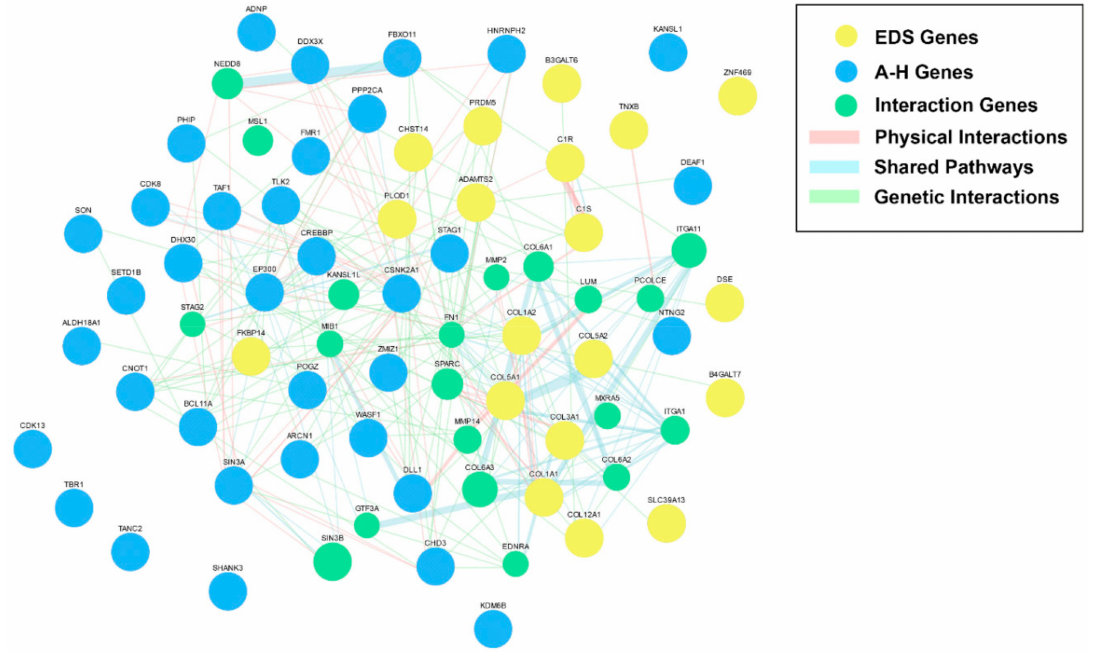
Figure 1. An extended interaction network of genes that are associated with OMIM syndromes comorbid with autism and hypermobility (A–H) (blue) and the Ehlers-Danlos syndromes (EDS) (yellow). An extended interaction network of nodes is shown in green. Direct physical interactions between gene nodes are shown in pink, shared pathways are shown in light blue, and genetic interactions are shown in light green. Note the substantial overlap between A–H and EDS genes, suggesting an extended interactive network and a possible explanation for phenotypic